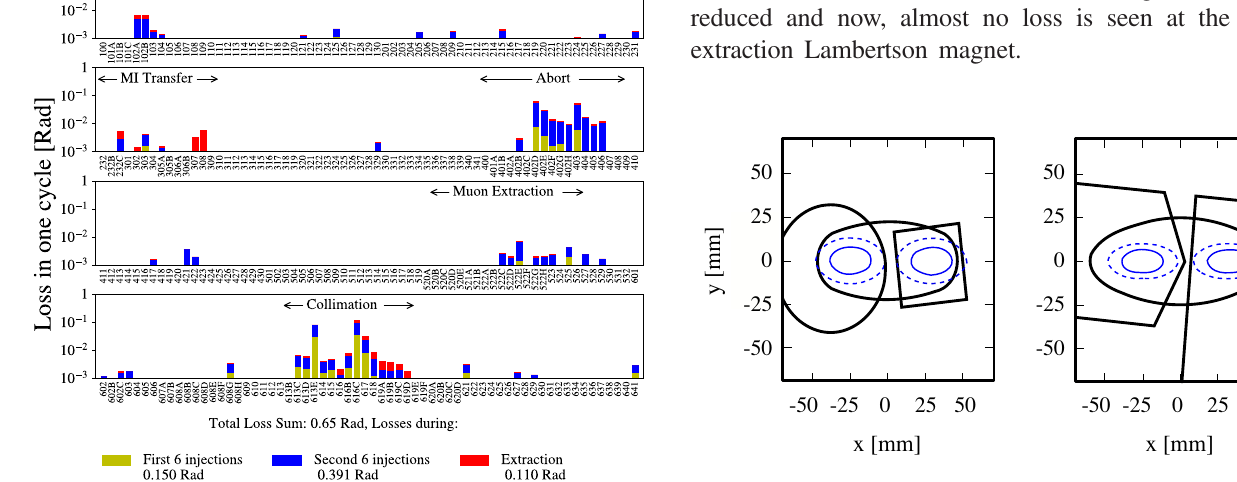
FIG. 10. The aperture sizes for the old Recycler permanent magnet Lambertson magnet (left) and the Main Injector MLAW Lambertson magnet (right). The solid line shows (cid:1) 3 σ and the dashed line (cid:1) 5 σ for 25 π mm mrad